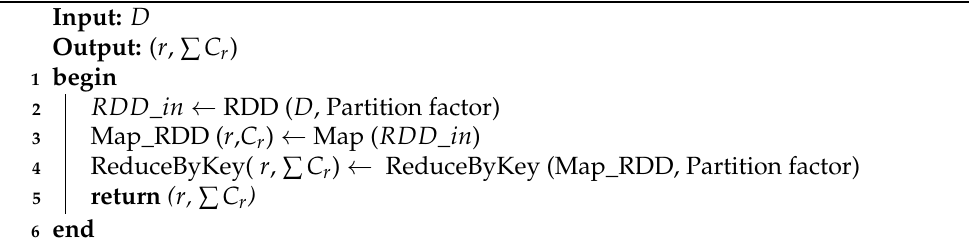
Algorithm 2: Phase 1—Initialization Phase of Spark